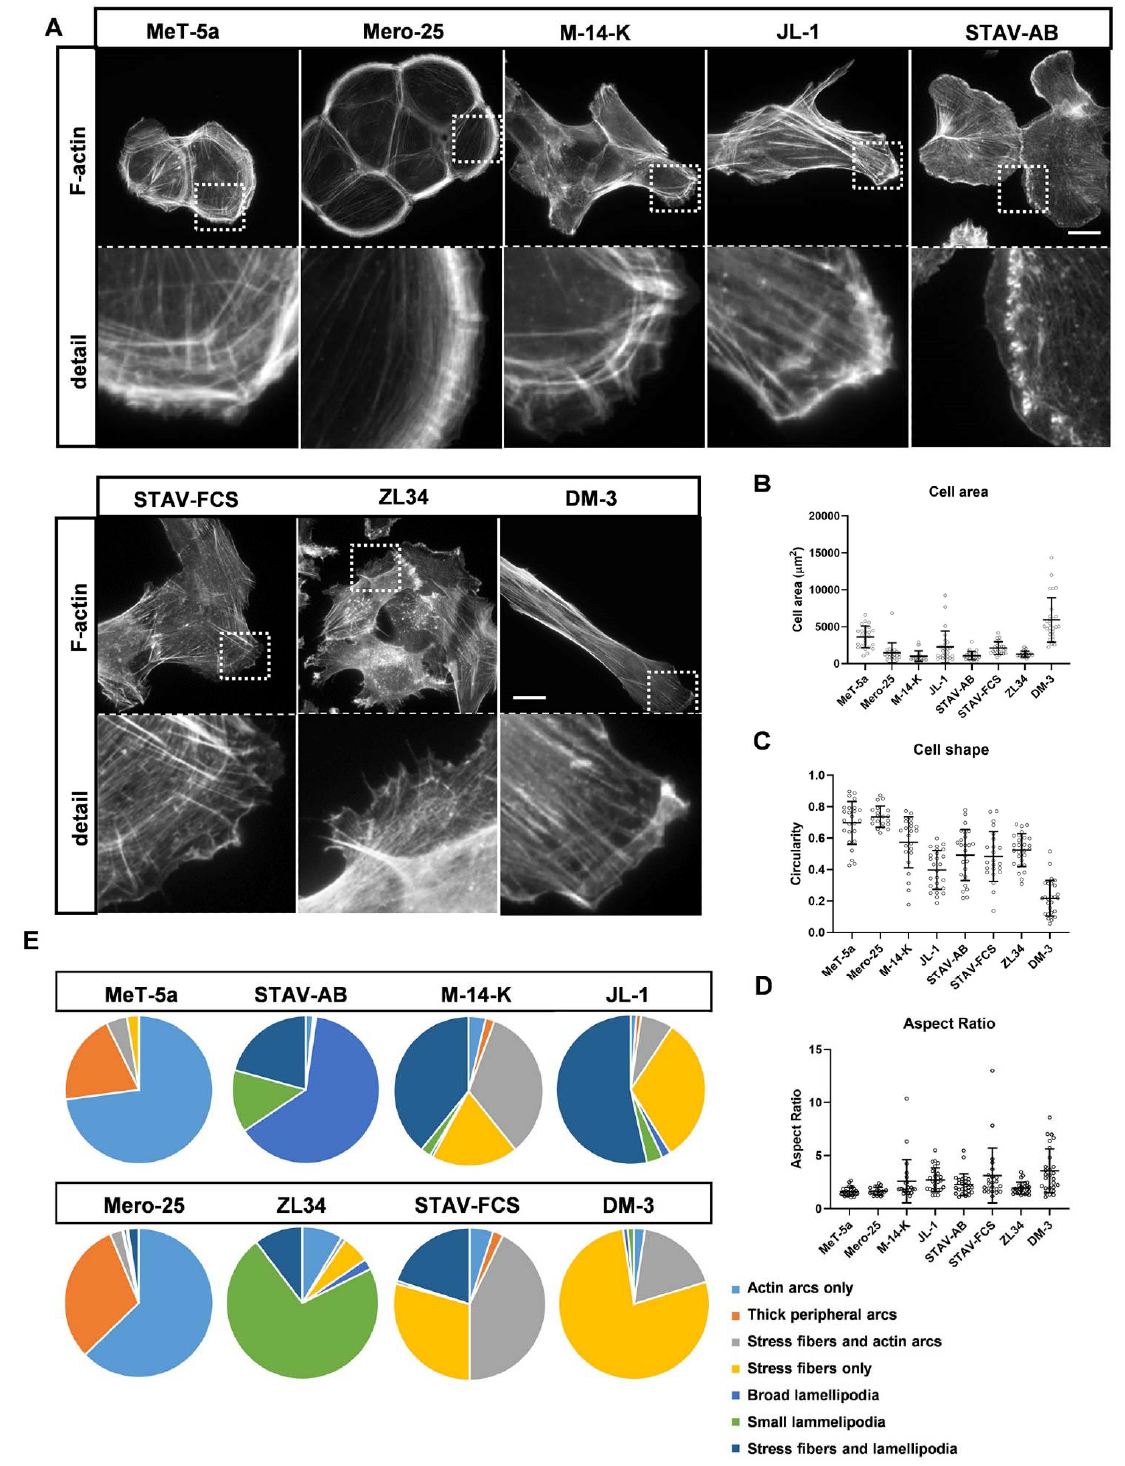
Figure 1. Actin filament organization and cell morphology. Representative images ( A ) for filamentous actin visualized with TRITC-conjugated phalloidin. Scale bar, 20 µm. ( B – D ). Quantification of cell area ( B ), circularity ( C ) and Aspect Ratio ( D ) was performed by ImageJ. MeT-5a ( n = 25), Mero-25 ( n = 20), M-14-K ( n = 23), JL-1 ( n = 26), STAV-AB ( n = 26), STAV-FCS ( n = 26), ZL34 ( n = 27), DM-3 ( n = 27). ( E ). Analysis of actin organization. 100 cells per cell lines were examined according to the dominant phenotype for each cell. The experiment was performed three times, i.e., in total 300 cells per cell lines were analyzed. One-way ANOVA with Tukey’s post hoc analyses were made to calculate statistical significance in panels ( B – D ). A complete list of the significances of the data is presented in Table